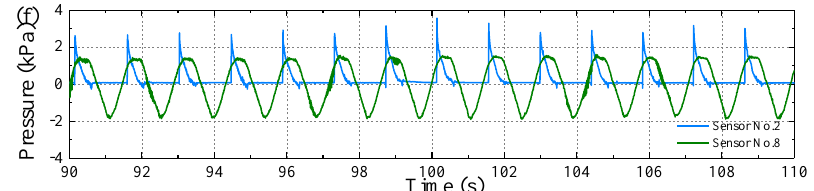
Figure 11. Result of a test condition in regular head waves: ( a ) wave elevation; ( b ) heave motion; ( c ) pitch motion; ( d ) bow vertical acceleration; ( e ) vertical bending stress (VBS) amidships; and ( f ) wave impact pressure.